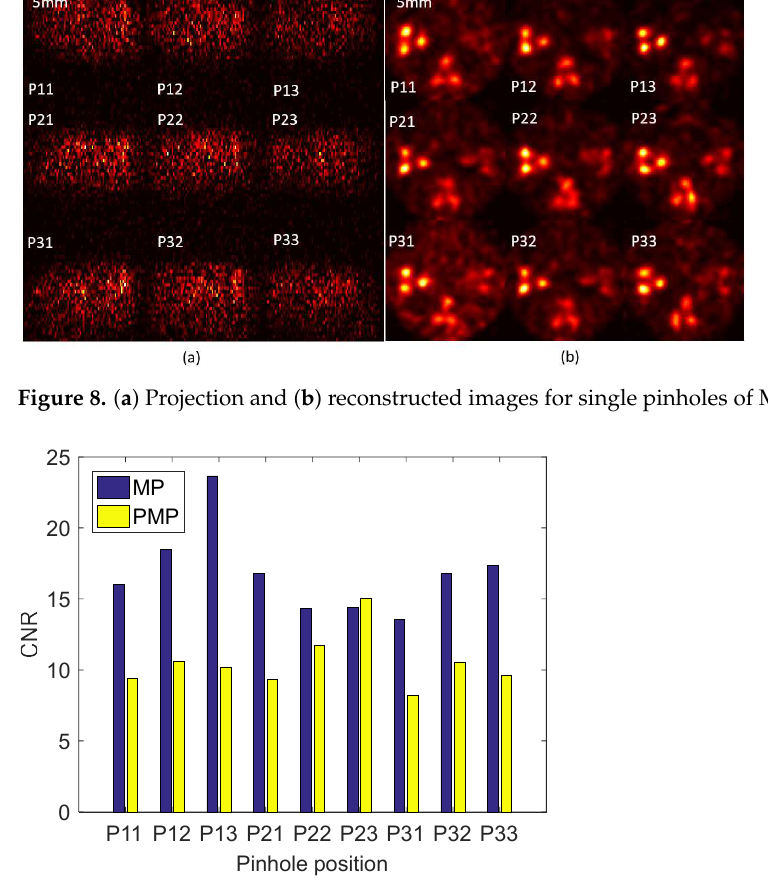
Figure 9. CNR of reconstructed images in PMP and MP geometries.